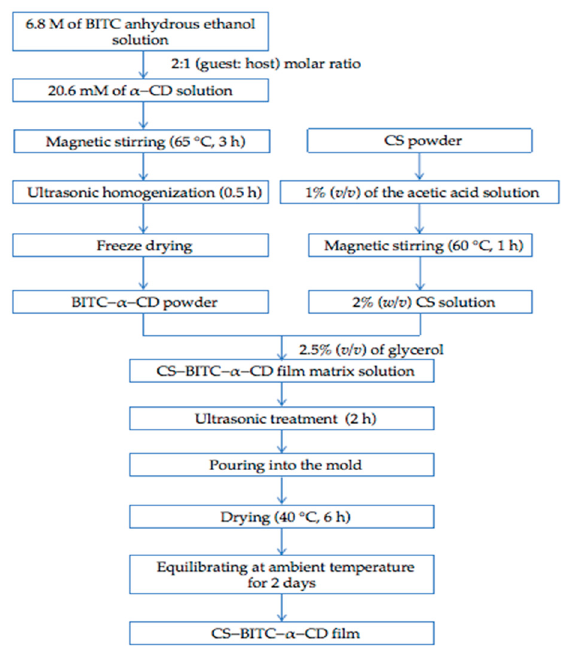
Figure 1. Procedures of fabricating the CS − BITC −α− CD composite film.